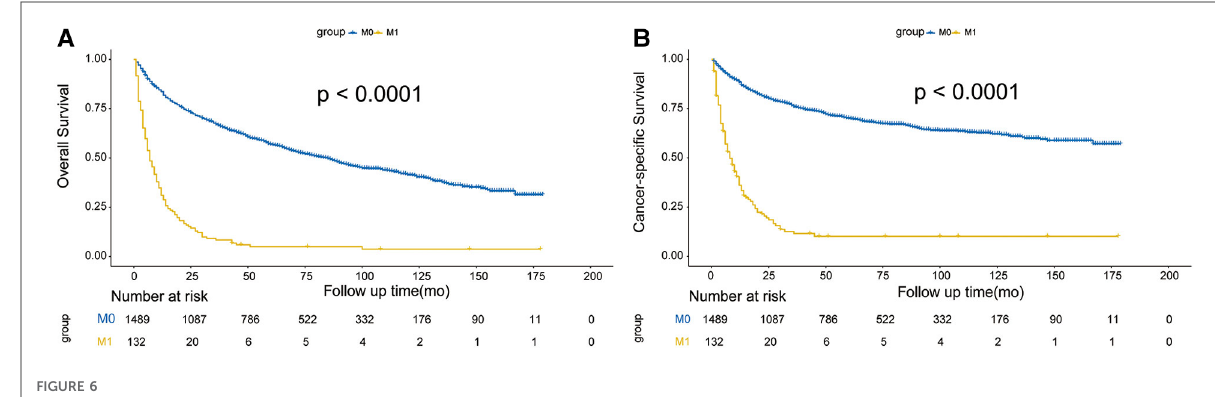
FIGURE 6 Effect of DM on OS ( A ) and CSS ( B ) in T1